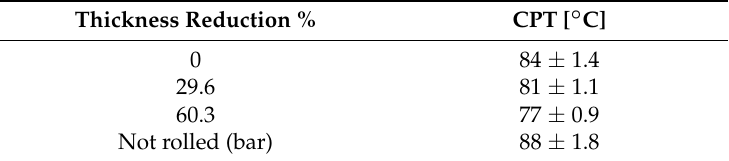
Table 4. CPT of the unwelded sheet metal. For comparison is also reported the CPT of a bar of UNS